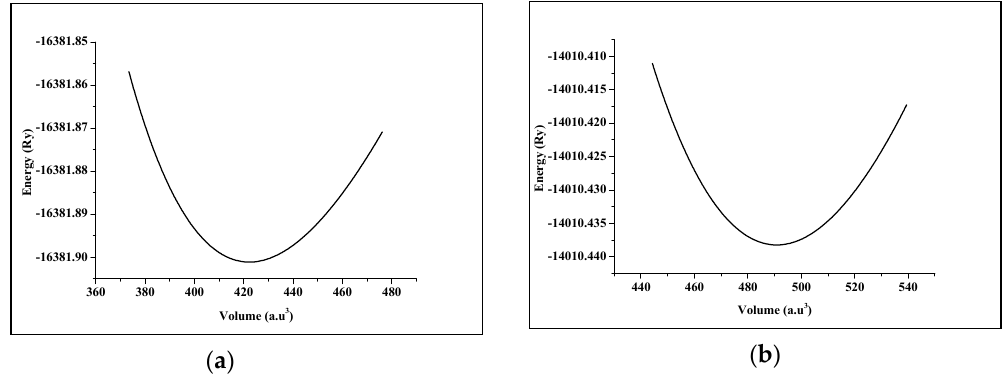
Figure 1. The crystal structure of SrTMO 3 (TM = Rh, Zr), (blue spheres are Sr atoms, red spheres are Oxygen O atoms and green spheres are TM atoms).